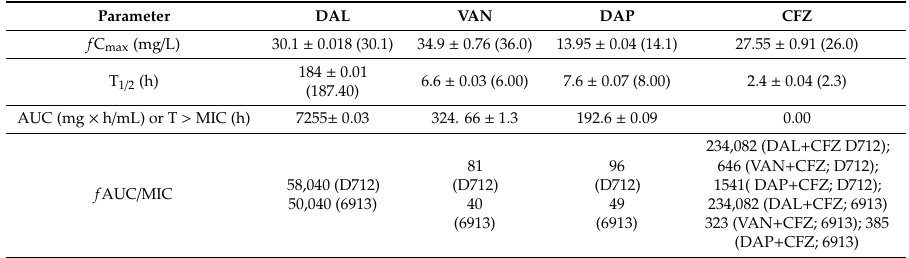
Table 2. PK parameters attained and targeted values (represented by parenthesis) in the PK / PD model.